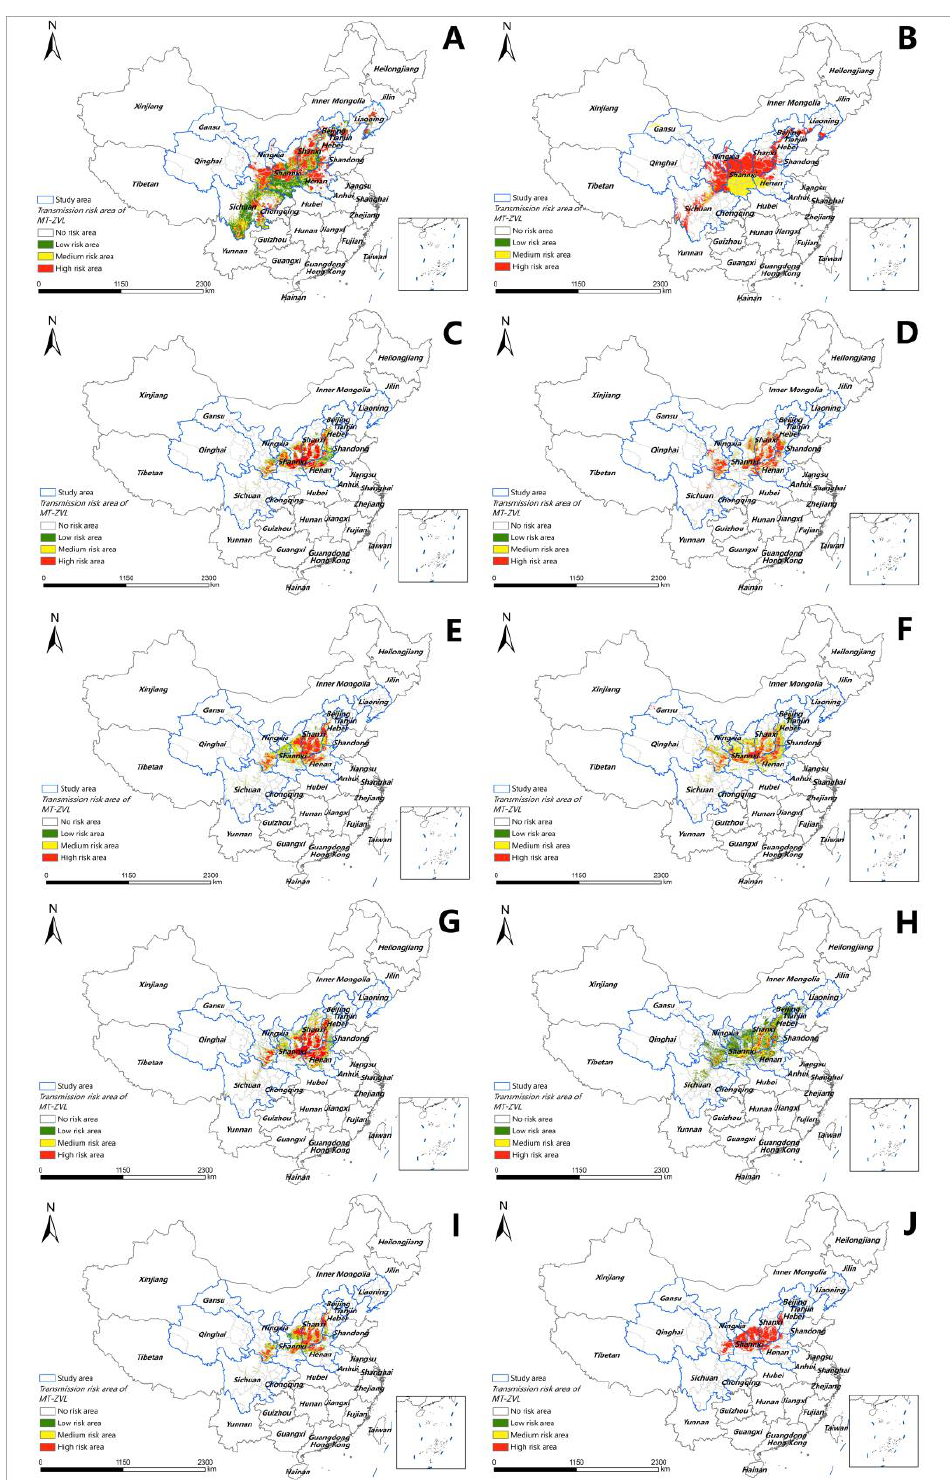
Figure 3. Prediction of areas at risk of mountain-type zoonotic visceral leishmaniasis transmission in China using ecological niche models based on climatic and environmental variables: ( A ) artificial neural network (ANN); ( B ) classification tree analysis (CTA); ( C ) flexible discriminant analysis (FDA); ( D ) generalized additive model (GAM); ( E ) generalized boosted model (GBM); ( F ) generalized linear model (GLM); ( G ) multivariate adaptive regression spline (MARS); ( H ) maximum entropy (MaxEnt) model; ( I ) random forest (RF); ( J ) surface range envelope (SRE) model.